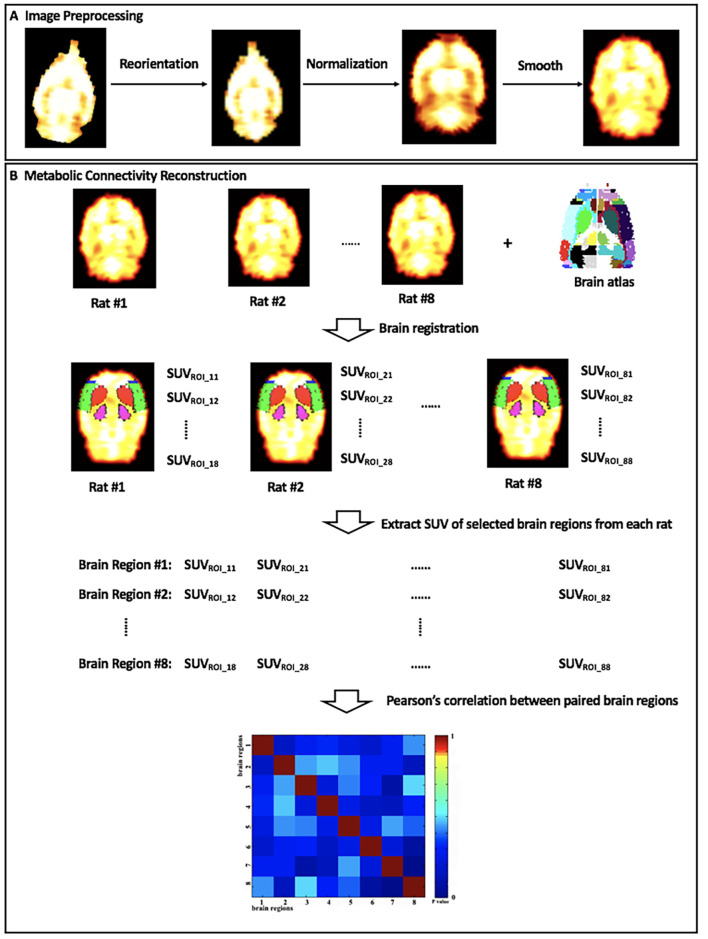
The diagram of (A) image preprocessing and (B) metabolic connectivity construction. SUVROI_ij, the standard uptake value (SUV) of brain region #j in rat #i.